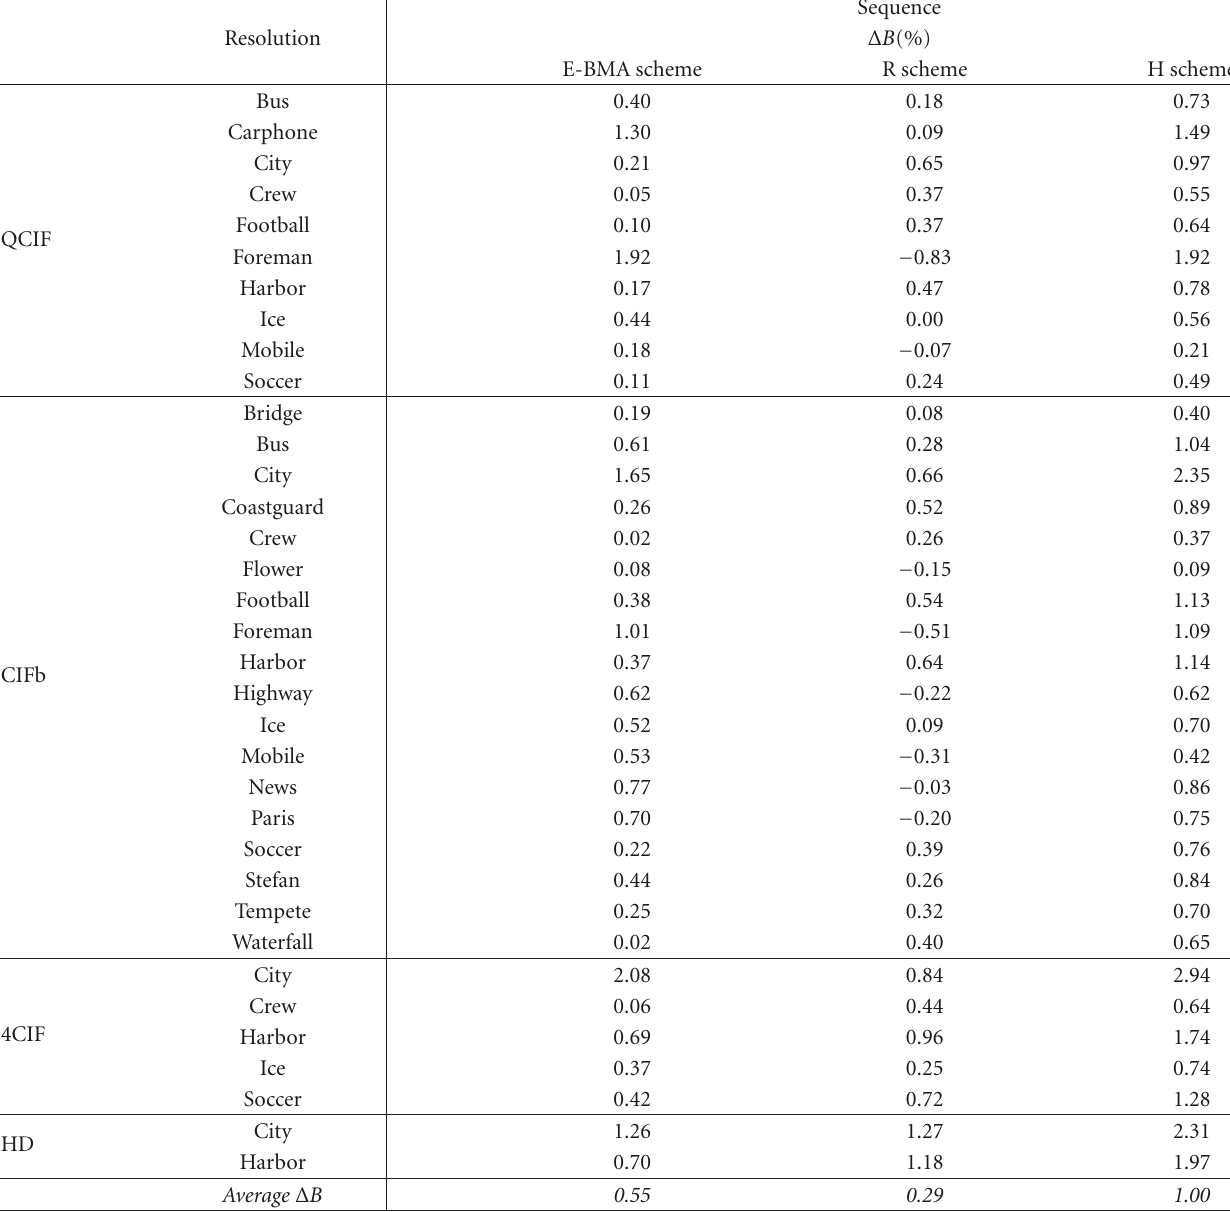
Table 3: The bitrate saved by E-BMA scheme, R scheme, and H